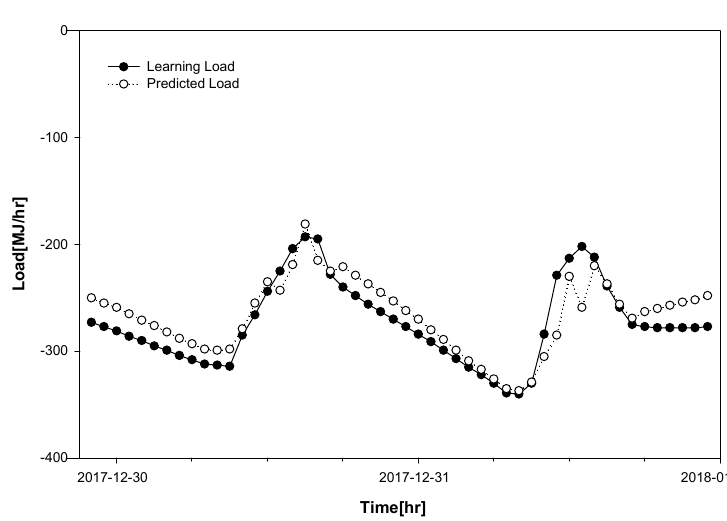
Figure 8. Indoor Load and Prediction Load trend over time.